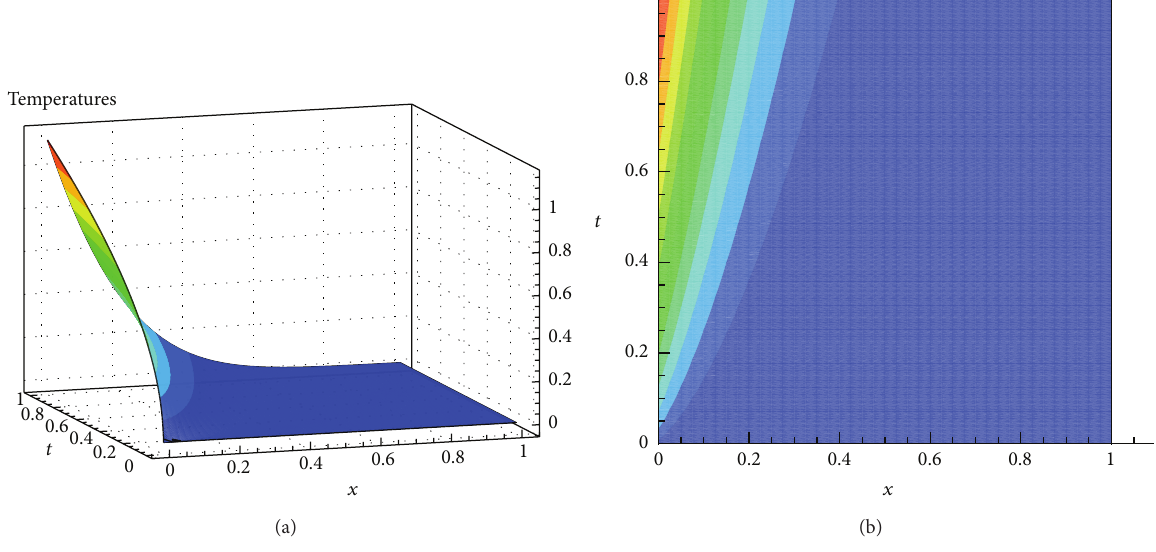
Figure 10: Numerical solution and contours when 𝑓(𝑡) = 1